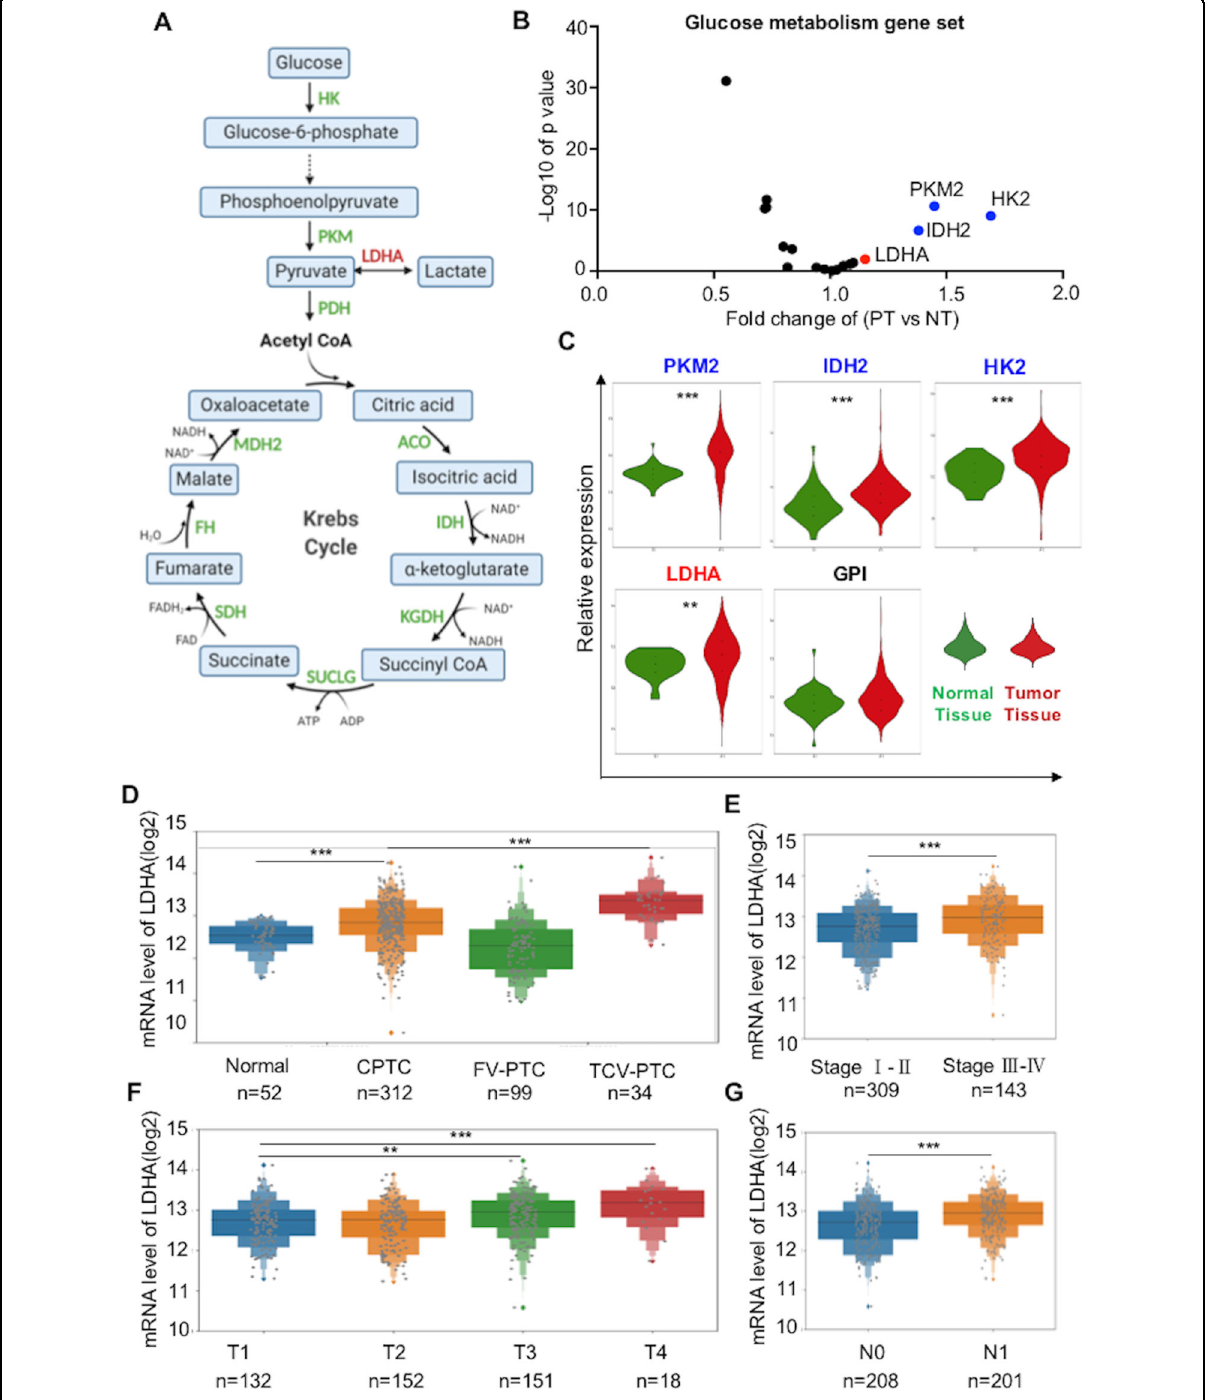
Fig. 1 Bioinformatics analysis of enzymes involved in glucose metabolism and identi fi es LDHA as a candidate target for PTCs. A Simpli fi ed scheme of glucose metabolism. B Fold change of glucose metabolic genes in primary tumor tissue versu s normal tissue. C Representative glucose metabolic genes that were upregulated in primary PTC tumors. D LDHA expression was higher in CPTC and TCV-PTC tissues than in normal tissues. E LDHA expression levels of patients in stage III/IV PTC were higher than those in stage I/II. F Patients in stage T3 and T4 had higher LDHA expression levels than those in stage T1 and T2. G Patients with lymph node metastasis (N1) had higher LDHA levels than those without lymph node metastasis (N0). All * p < 0.05, ** p < 0.01, *** p <